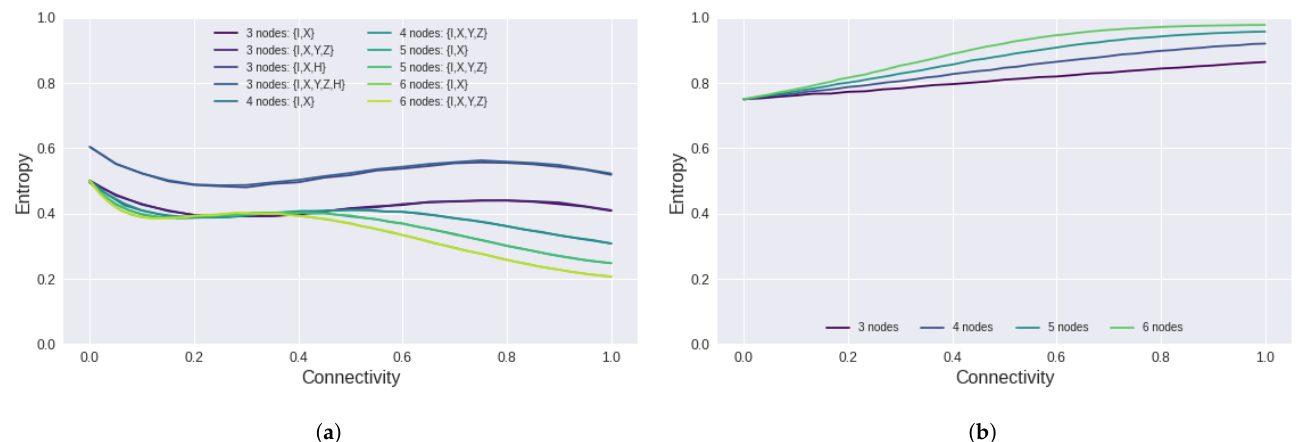
Figure 4. Entropy for different QBN configurations is shown in panel ( a ). In order to allow a comparison between networks of different sizes, we normalized the connectivity value. Panel ( b ) shows the entropy for RevBNs of different sizes. A detailed version of the entropy for QBNs and RevBNs can be consulted in Figures A3 and A4,